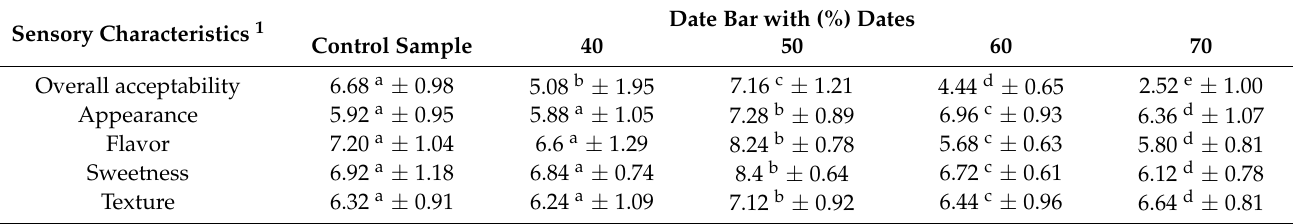
Table 3. Sensory characteristics of snack bar